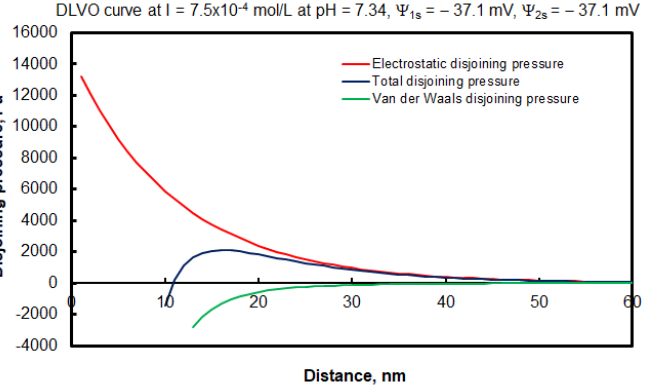
approaching bubbles at ionic strength I = 7.5 × 10 − 4 mol/L and pH = Figure 4. DLVO curves of the electrostatic, van der Waals, and total disjoining pressure of two ap ‐ proaching bubbles at ionic strength I = 7.5 × 10 − 4 mol/L and pH = 7.34.